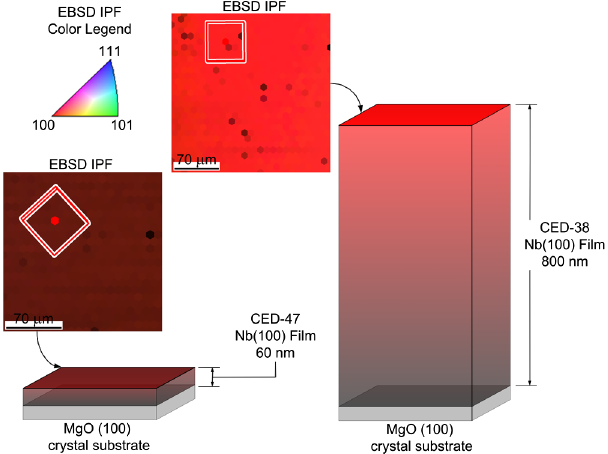
FIG. 4 (color online). Schematic illustration of Nb films CED-47 and CED-38. Their surface crystal quality was measured by EBSD. It indicates the Nb film crystal quality progressively evolves by thickening. They are the EBSD inversed pole figures of Nb film sample CED-47 and CED-38. EBSD survey area is 250 × 250 μ m, scan step 10 μ m. IPF grayscales are rendered